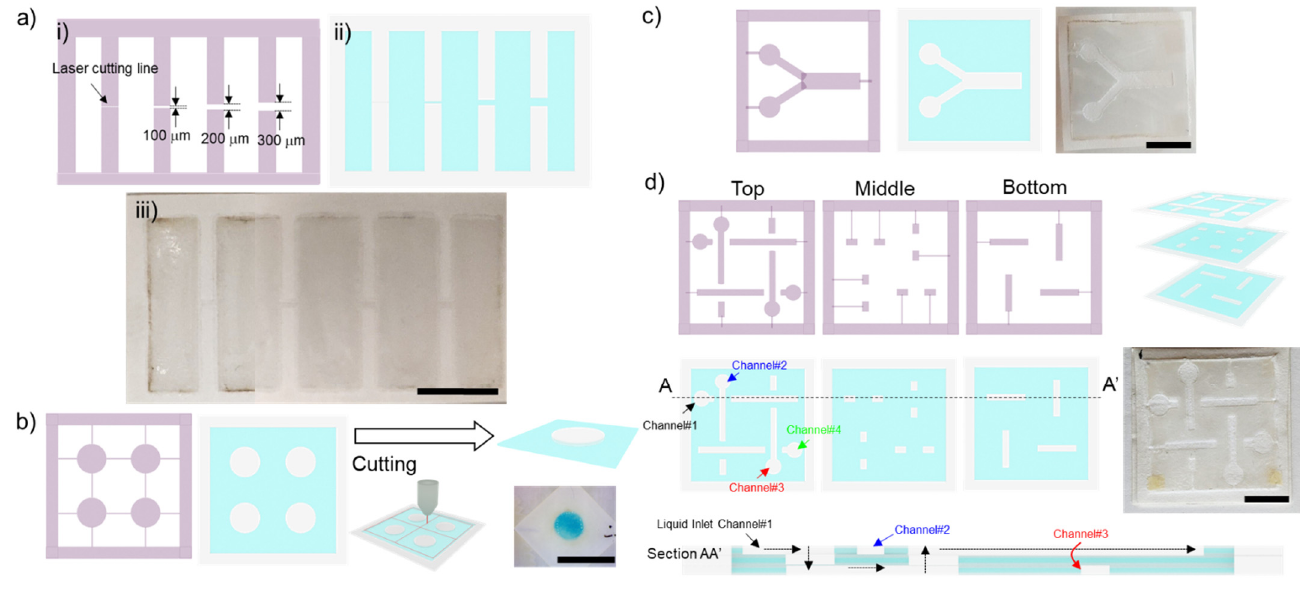
Figure 2. Laminate film for patterning masks with the laser cutting machine: ( a ) ( i ) pattern for investigating the resolution of the hydrophobic barrier ( ii ) the proposed pattern with gaps ranging from 100 to 300 µm after fabrication and ( iii ) the paper-based device after fabrication; ( b ) Pattern for the paper-based colorimetric sandwich immunological assay; ( c ) pattern for diffusive mixing in the 2D analytical paper-based device; ( d ) pattern of layers for constructing a 3D paperfluidic device and cross-sectional view of the 3D paper channel. Blue colour indicates the hydrophobic area, and white colour indicates the hydrophilic area. Scale bar is 1 cm.